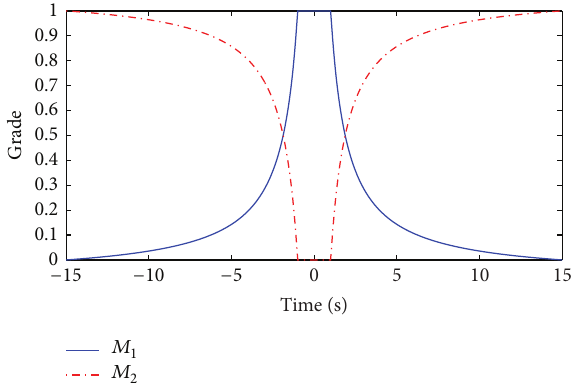
Figure 7: (a) The responses of